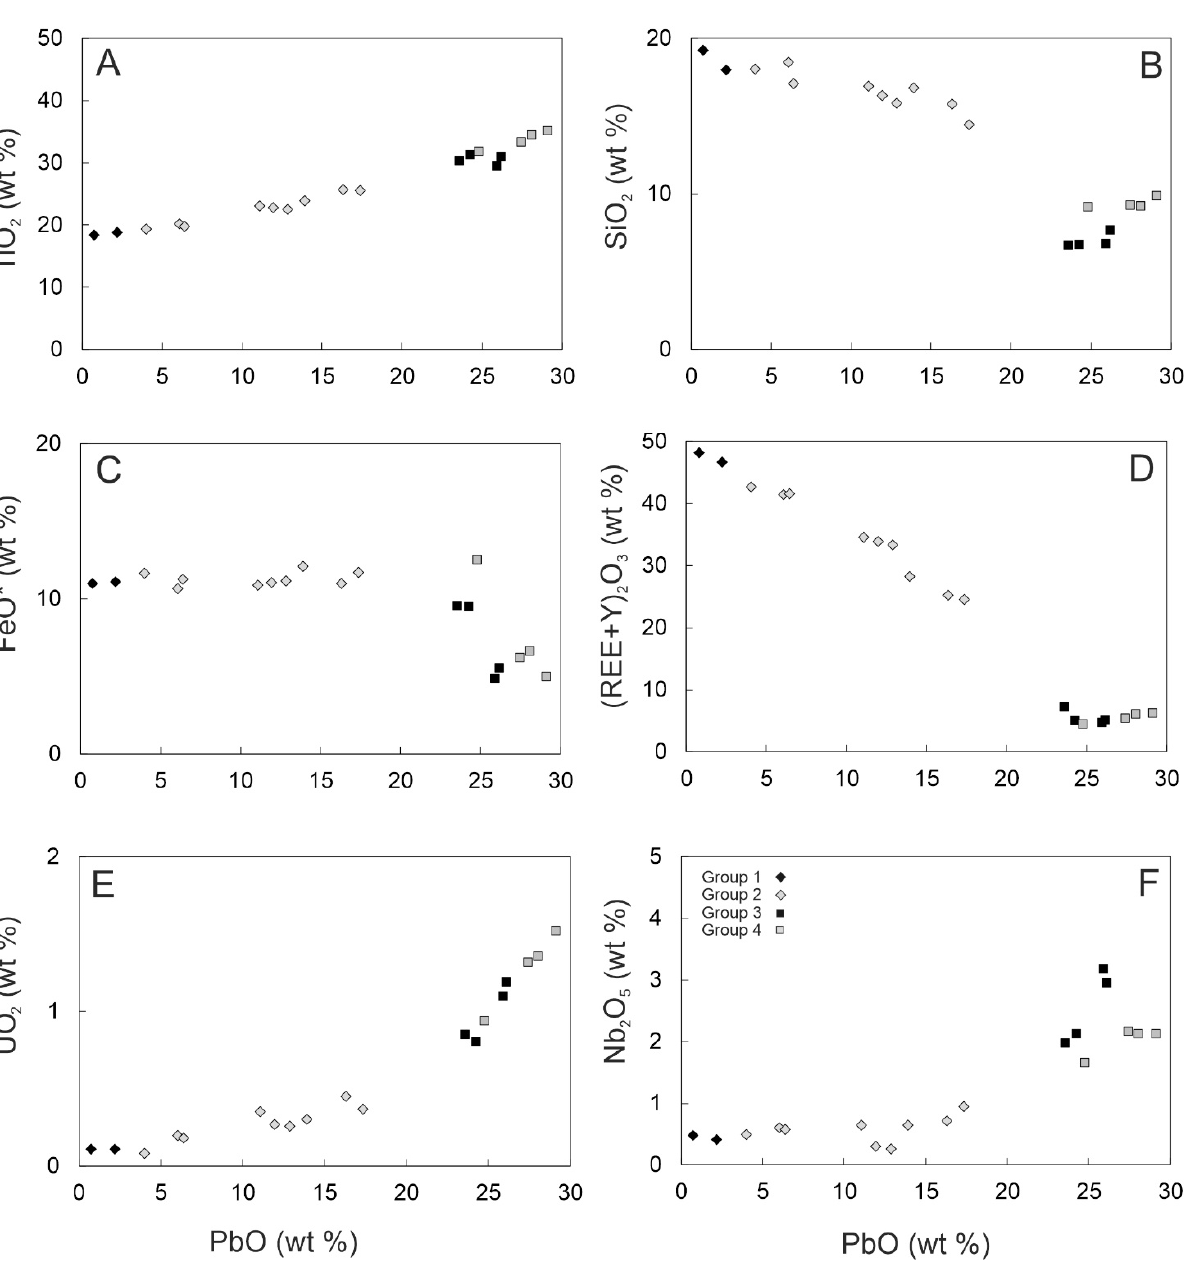
Figure 4. Compositional relationships between the groups shown on PbO v. ( A ) TiO 2 , ( B ) SiO 2 , ( C ) FeO*, ( D ) REE+Y) 2 O 3 , ( E ) UO 2, ( F ) Nb 2 O 5 , plots.